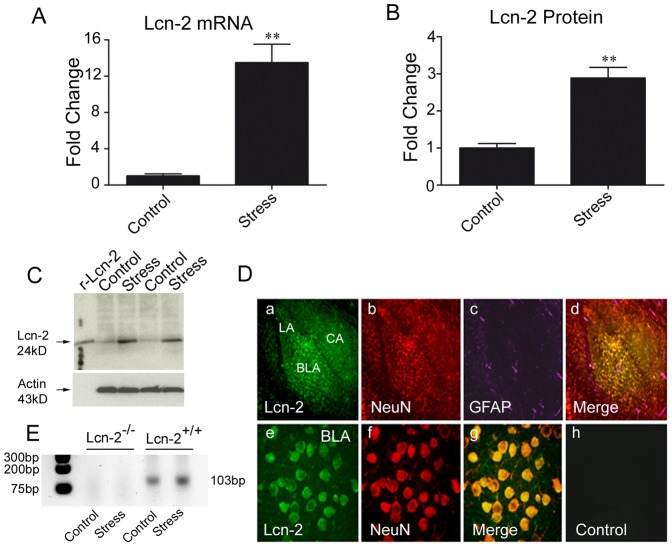
Lipocalin-2 is upregulated by psychological stress in mouse amygdala.Psychological stress induces lipocalin-2 gene expression N = 5, ** p<0.01 (A) followed by protein synthesis (B and C); R-Lcn-2– recombinant lipocalin-2 N = 3, ** p<0.01. Data are expressed as mean ± SEM. Panel C consist representative Western blot. Triple immunohistochemistry revealed (D) that Lcn-2 (green) is localised mostly within and nearby of neurons (a and e) co-localised with neuronal marker (b and f) NeuN (red) and to lesser extend with astrocyte marker (purple) GFAP (c and g) in the nucleus of basolateral amygdala. The secondary antibody showed no signal resulting from nonspecific binding (h). LA, Lateral Amygdala; BLA, Basolateral Amygdala; CA, Central Amygdala. Quantitative RT-PCR reaction confirmed lack of expression of Lcn-2 gene in Lcn-2−/− animals (E).